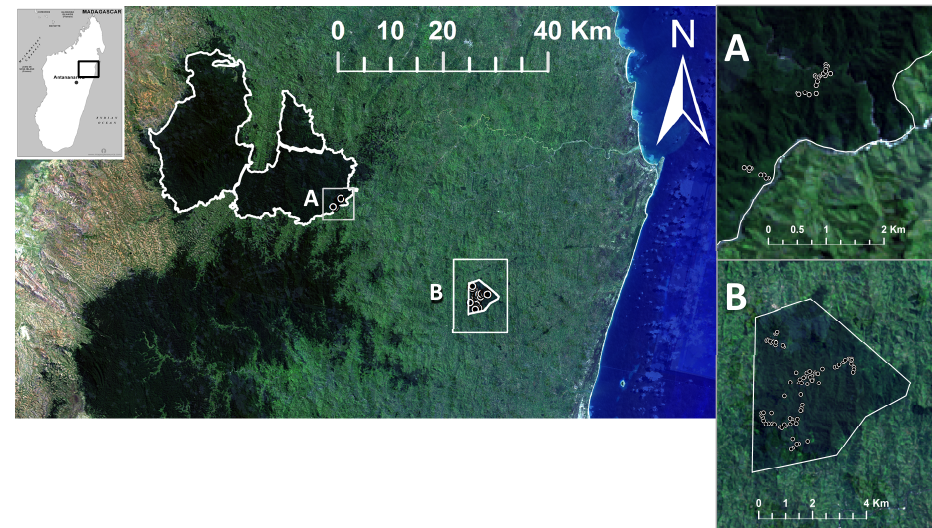
Figure 1. The location and proximity of the forest inventory plots in Zahamena National Park (ZNP) and Betampona (BTP). Inset box ( A ) indicates the locations of the 35 plots in ZNP as white dots, with the boundary of ZNP shown in white. The boundary of BTP is outlined in white in inset box ( B ), with white circles representing the locations of the 100 inventory plots.